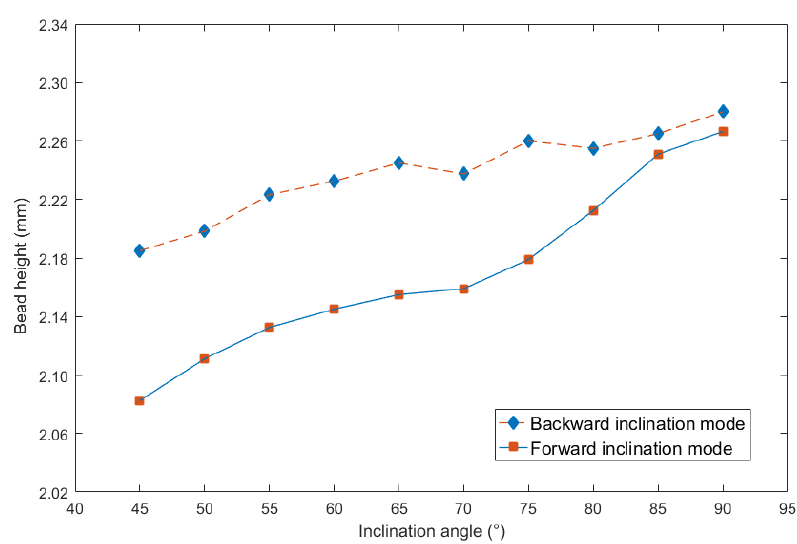
Figure 5. Curve between inclination angle and bead height.